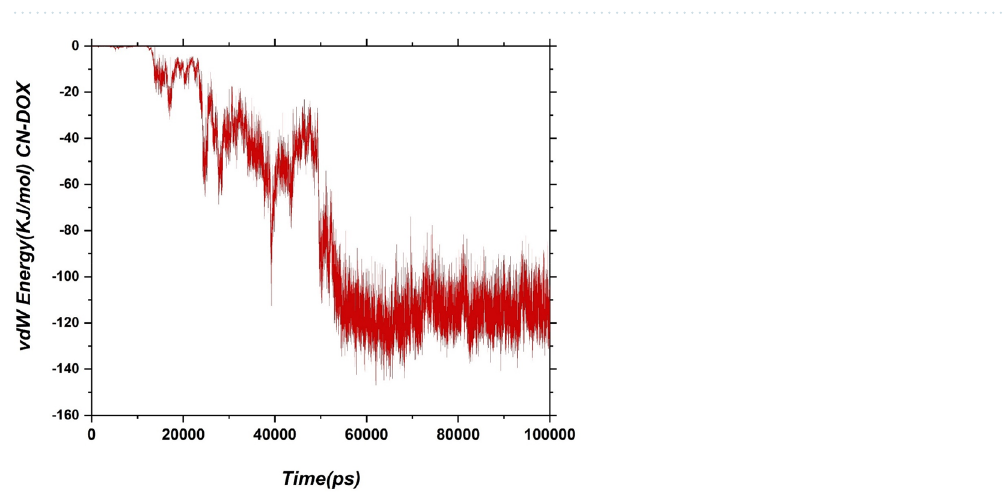
Figure 2. Representative snapshots corresponding to the interaction of DOX molecules with CN nanosheet at three different times: ( a ) 0 ns, ( b ) 42 ns, ( c ) 100 ns.